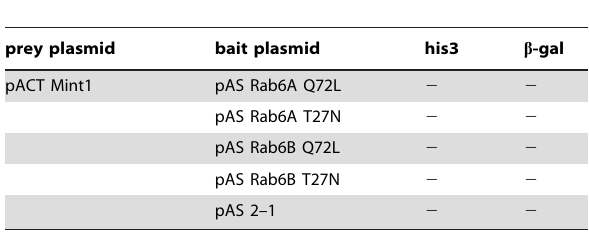
Table 2. Full length Mint1 does not interact with Rab6.